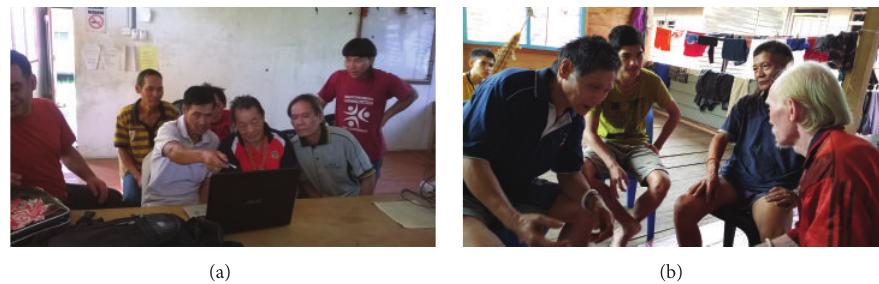
Figure 10: (a) Community discussion in Long Lamai. (b) Community discussion in Long